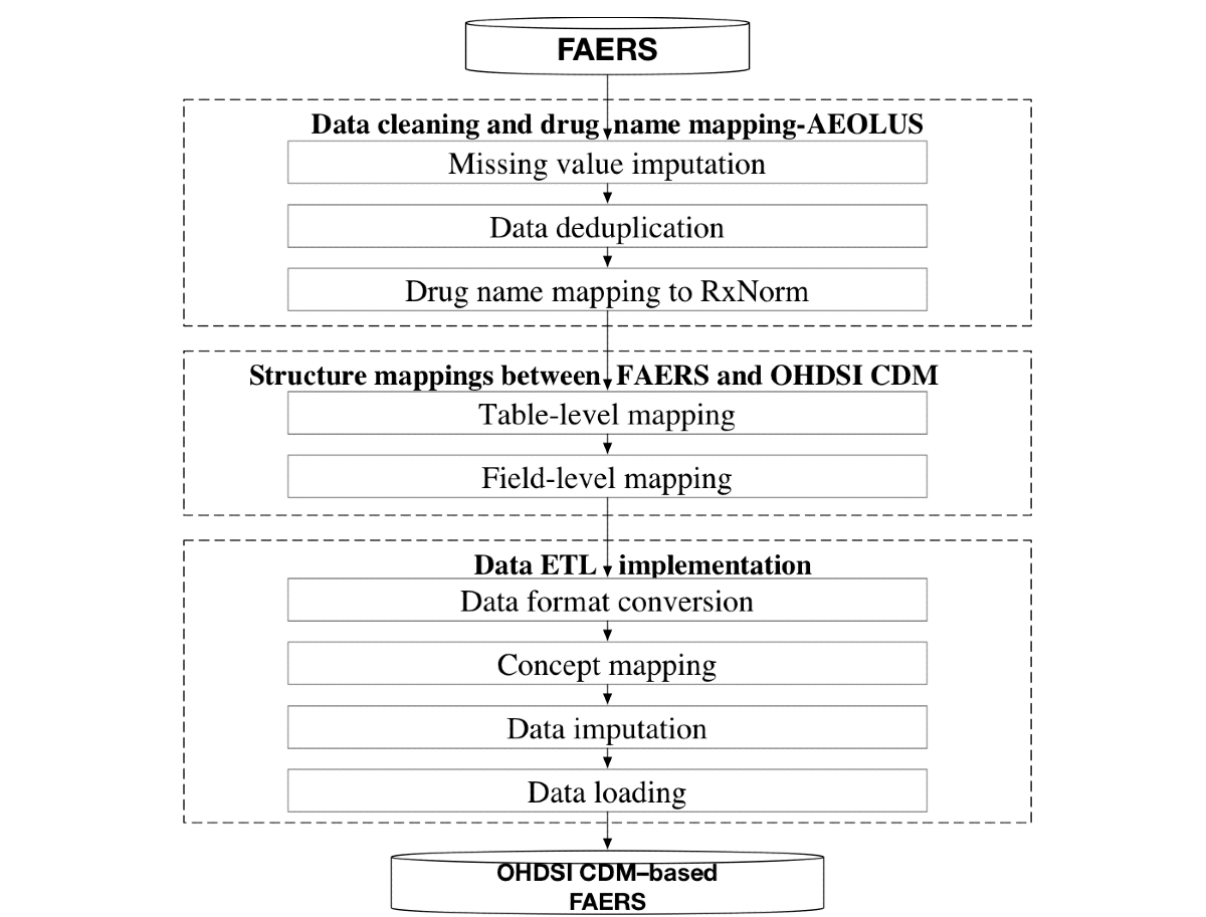
Figure 2. Extract, transform, and load process of converting Food and Drug Administration’s Adverse Events Reporting System into Observational Health Data Sciences and Informatics common data model. AEOLUS, adverse event open learning through universal standardization; CDM, common data model; ETL: extract, transform, and load; FAERS, Food and Drug Administration’s adverse event reporting system; OHDSI, observational health data sciences and